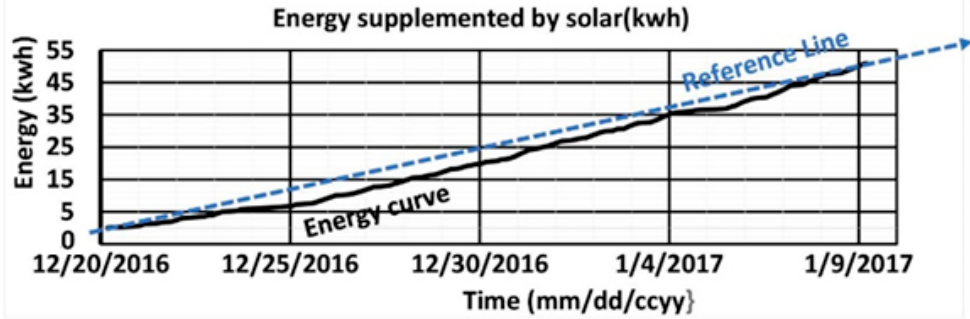
energy is used as supplement.